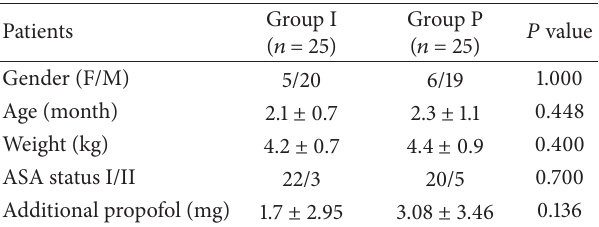
Table 1: Demographic data and additional doses of propofol. Values are mean ± standard deviation or number.